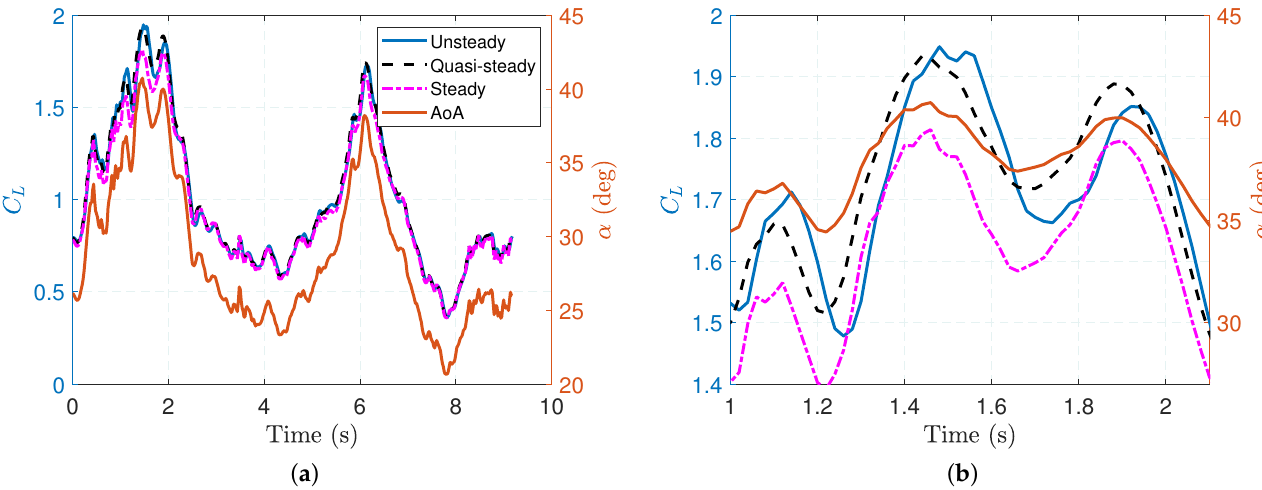
Figure 9. Lift coefficient for unsteady, quasi-steady and steady UnPaM simulations for the kinematics resulting from the figure-of-eight maneuver under study. ( a , b ) give the full trajectory and and a zoom-in,